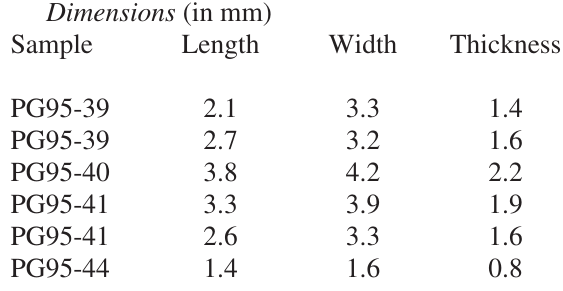
large, hypothyrid with narrow deltidial